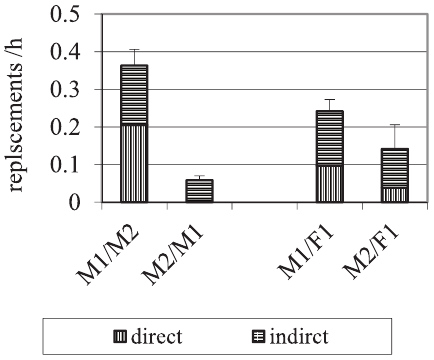
Figure 6. Direct and indirect replacements/h by M (±SE for the total number of replacements).